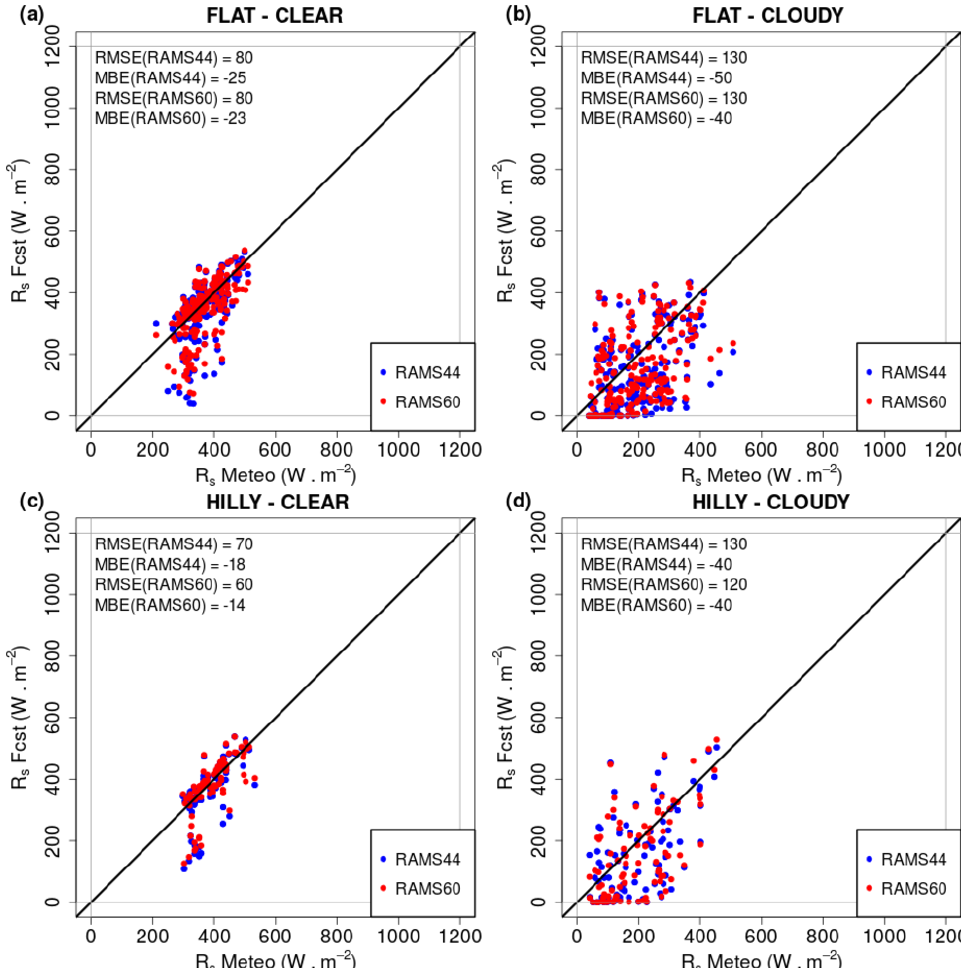
Figure 5. Same as Figure 4, but during the winter 2010–2011: flat-clear ( a ); flat-cloudy ( b ); hilly-clear ( c ) and hilly-cloudy ( d ). Statistical scores values (RMSE and MBE) presented in W·m − 2 .